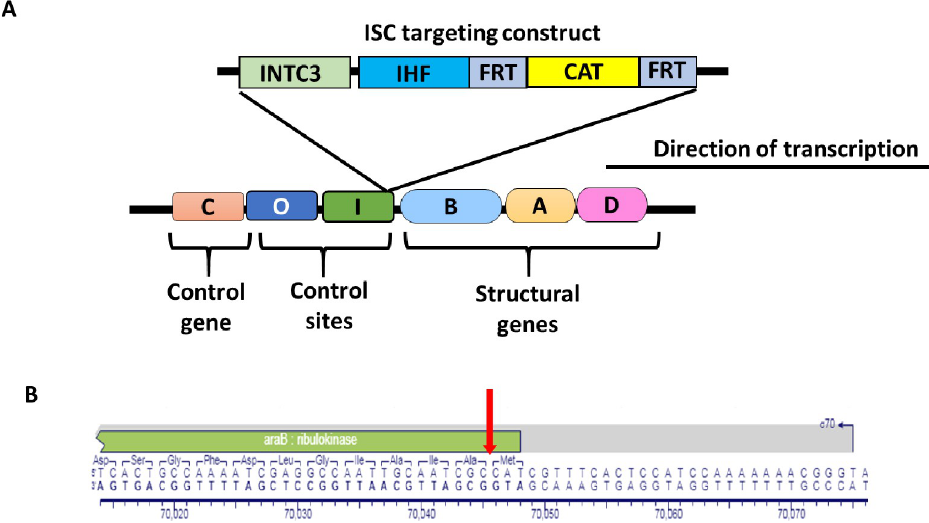
Fig 1. Genetic modification of strain MG1655-ISC . ( A ) Diagram of the ara operon with the inserted gene cassette composed of integrase variant C3 (INTC3), single chain integration host factor 2 (IHF), recombination sites for Flp recombinase (FRT) as direct repeats and chloramphenicol resistance cassette (CAT). The direction of transcription of the modified ara operon is indicated. ( B ) The red arrow demarcates the precise position of ISC insertion by homologous recombination between start and alanine codons of araB as verified by